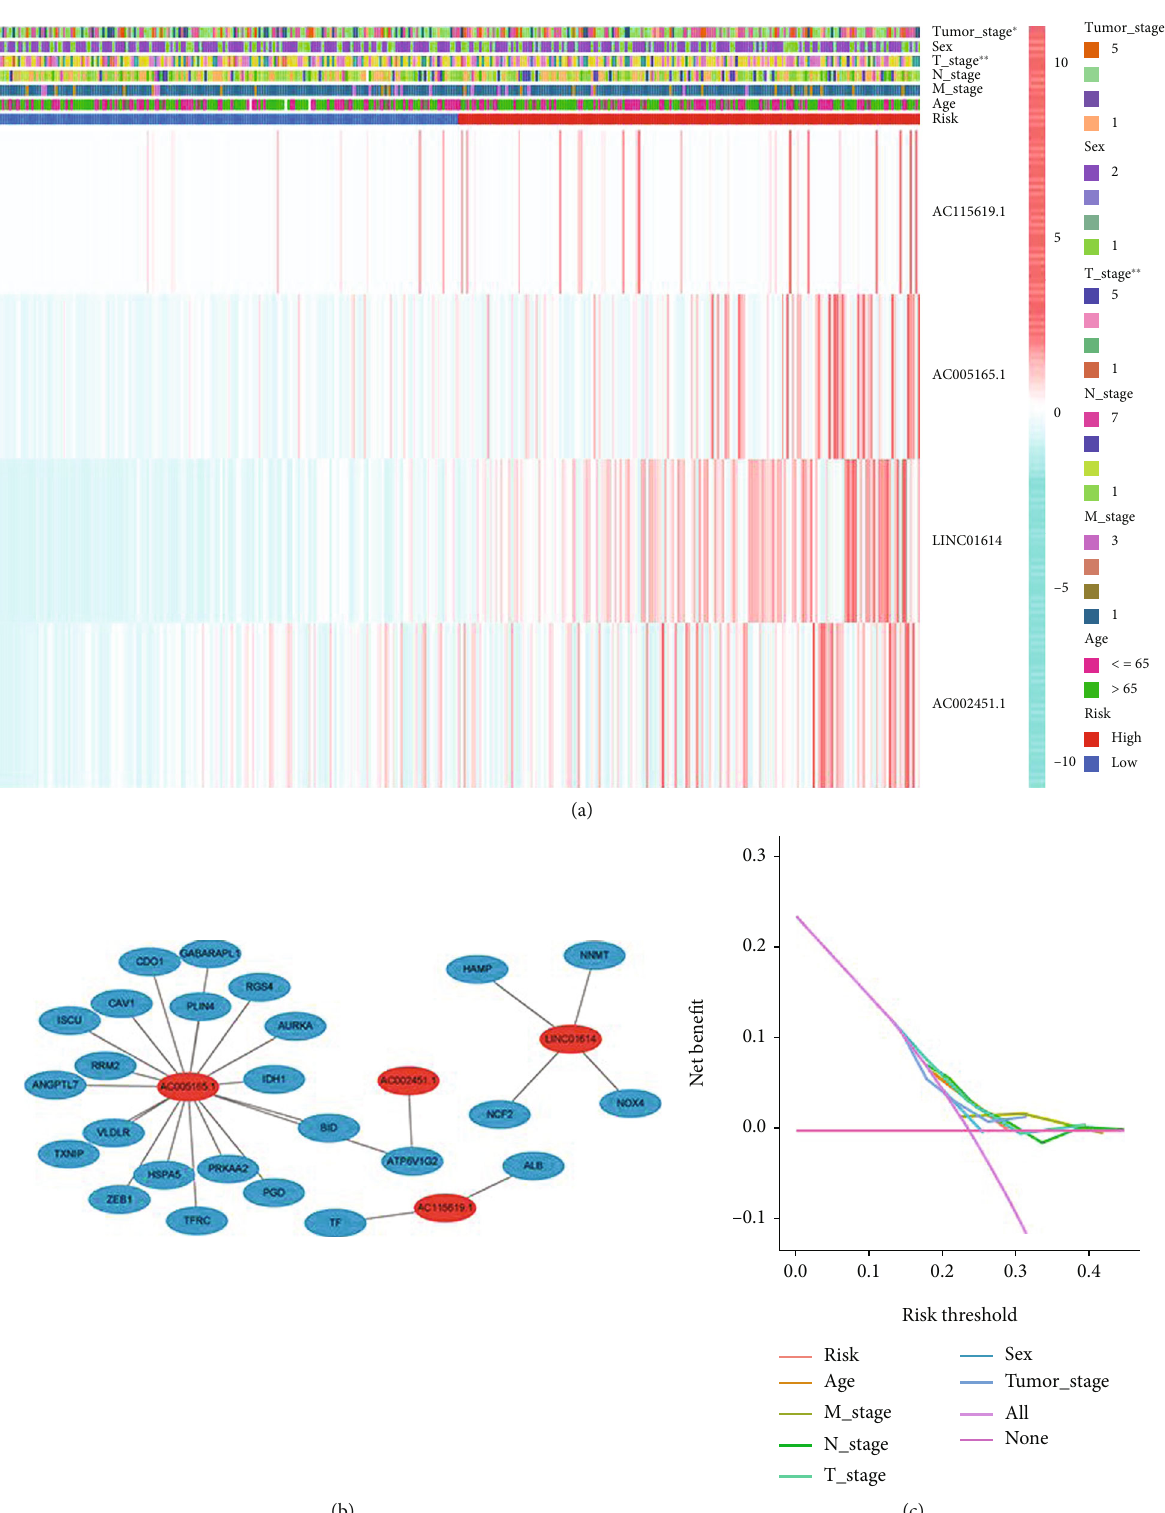
Figure 5: The analysis of the correlation between the prognostic characteristics of ferroptosis-related lncRNA and clinicopathology. (a) Heat map of the prognostic characteristics and clinicopathological correlation of ferroptosis-related lncRNAs. (b) Coexpression network: the red nodes represent ferroptosis-related lncRNAs, and the green nodes represent ferroptosis-related genes. (c) DCA for di ff erent risk